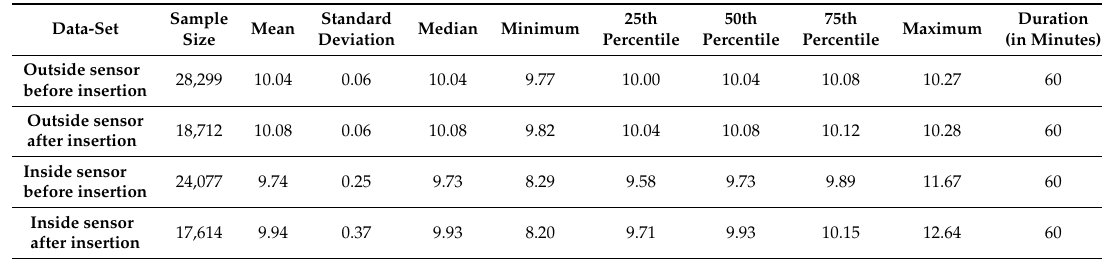
Table 3. Measures of Central Tendency.